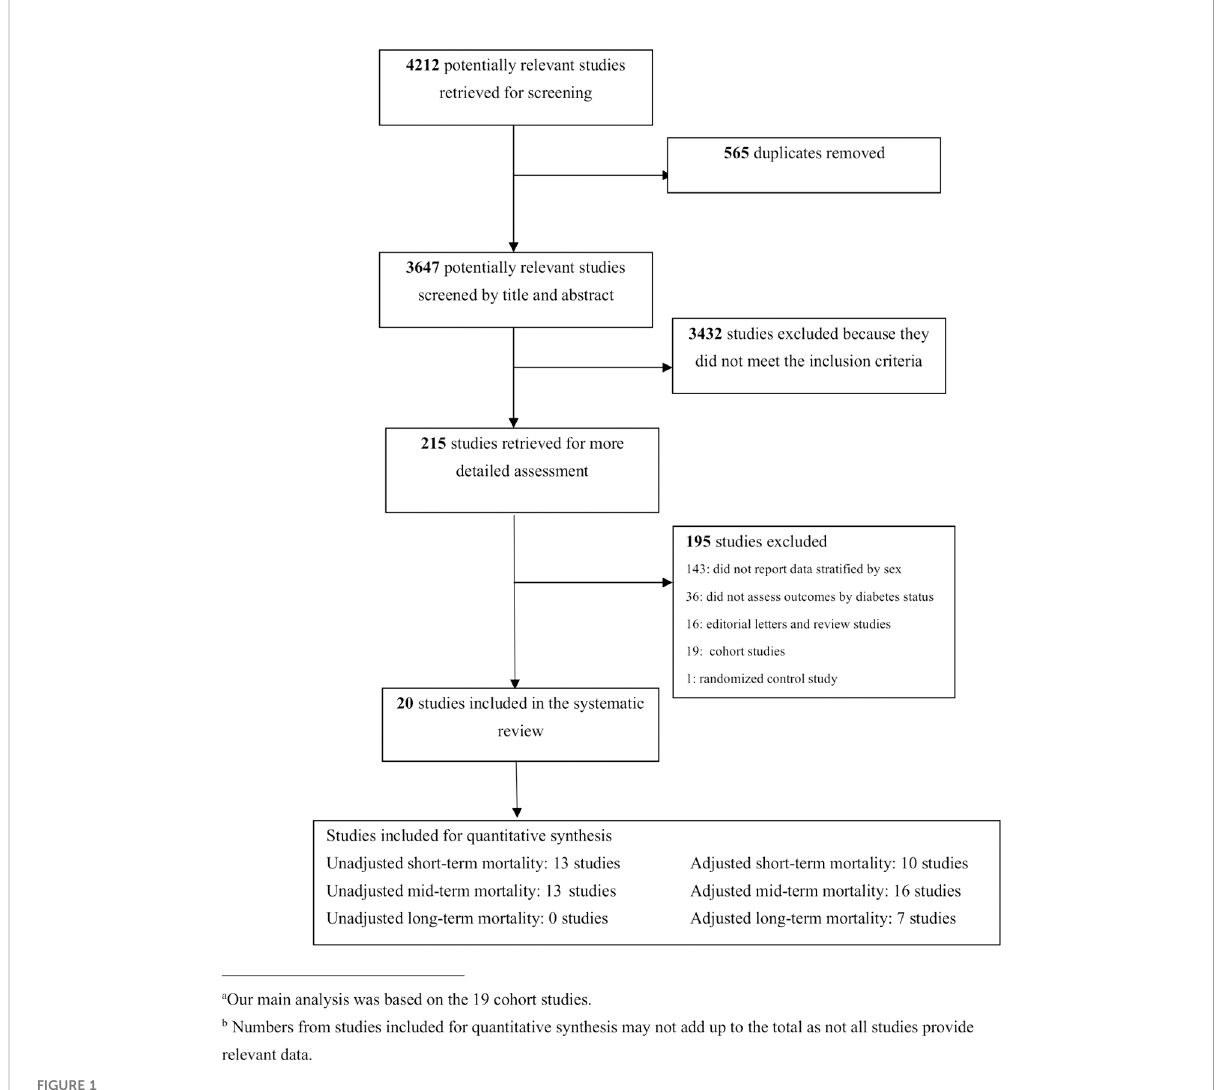
FIGURE 1 Flow diagram of study for review based on inclusion and exclusion criteria ab